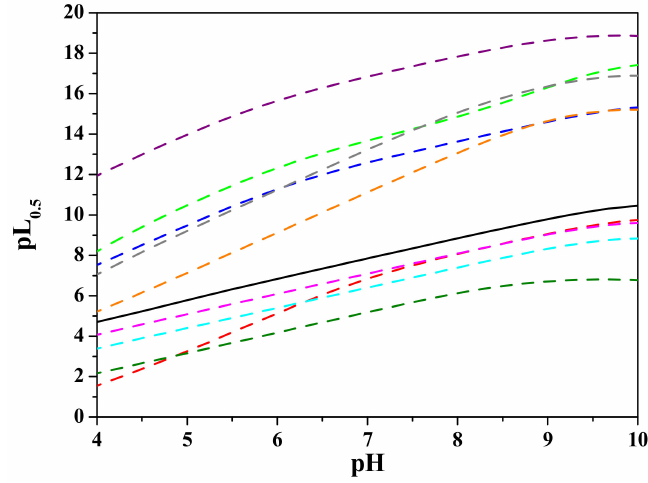
Figure 4. Comparison of the pL 0.5 of various complexones toward Cd 2+ at I = 0.1 mol dm − 3 and T = 298.15 K at different pH values. Complexones: EDDS (red), TTHA (green), EDTA (blue), DTPA (gray), MGDA (magenta), NTA (cyan), EGTA (orange), CDTA (purple), HIDA (olive), GLDA